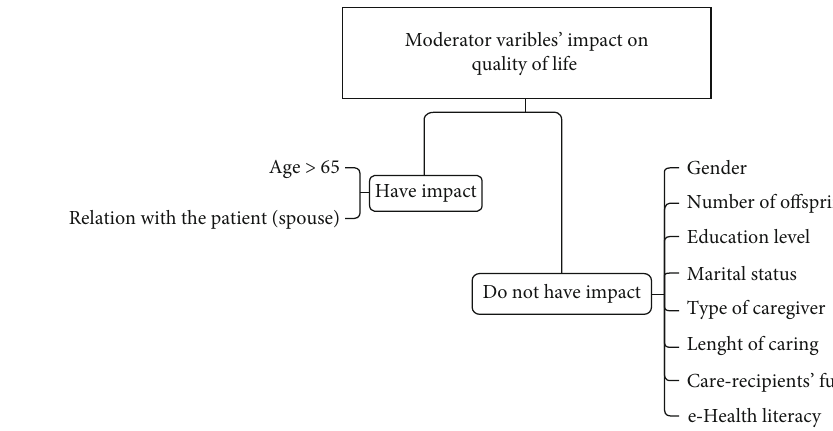
Figure 2: Impact of VCoP on caregivers ’ overall quality of life: moderator variables. Table 6: Themes and